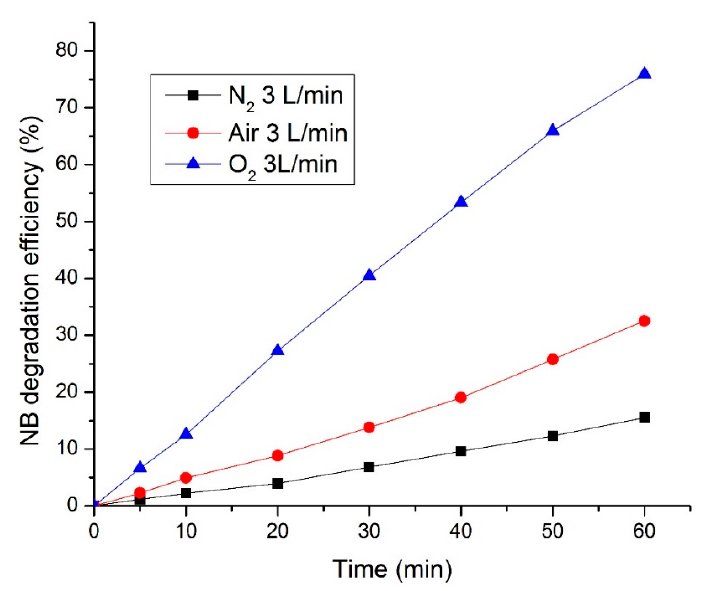
Figure 5. The effect of different carrier gases on the degradation of NB in the DBD reactor, at NB concentration of 20 mg/L, gas flow rate of 3 L/min and an applied voltage of 1.8 kV.